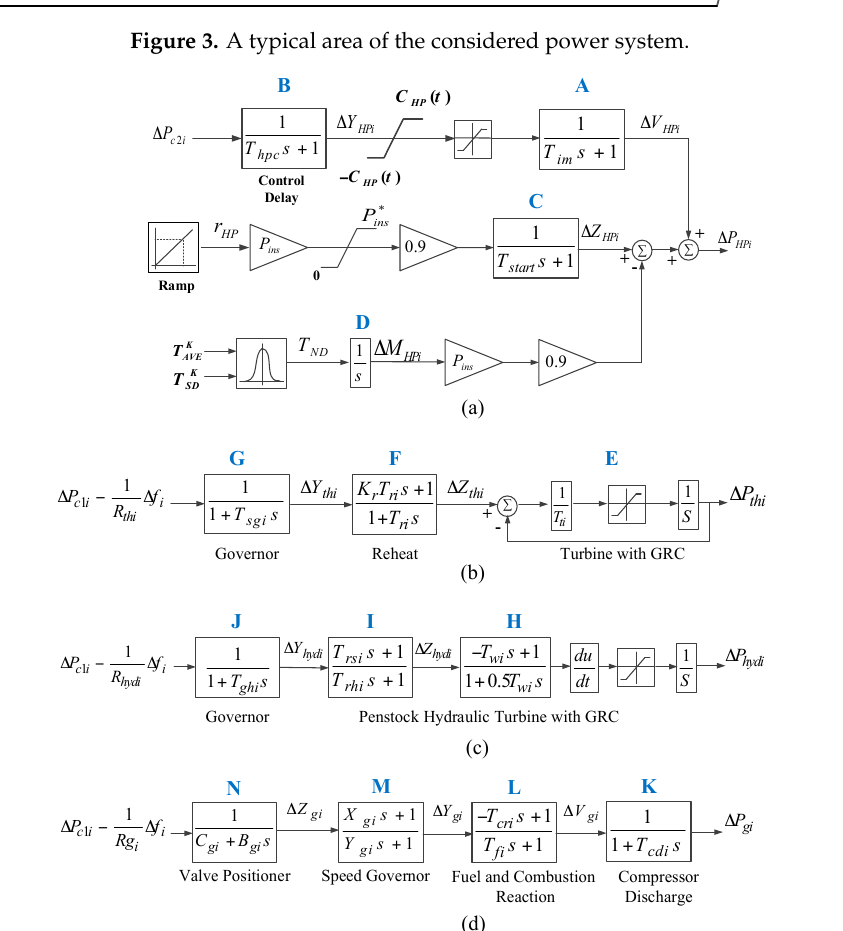
Figure 4. State-space model of: ( a ) HPWH, ( b ) thermal unit, ( c ) hydro unit and ( d ) gas unit. GRC, generation rate constraint.